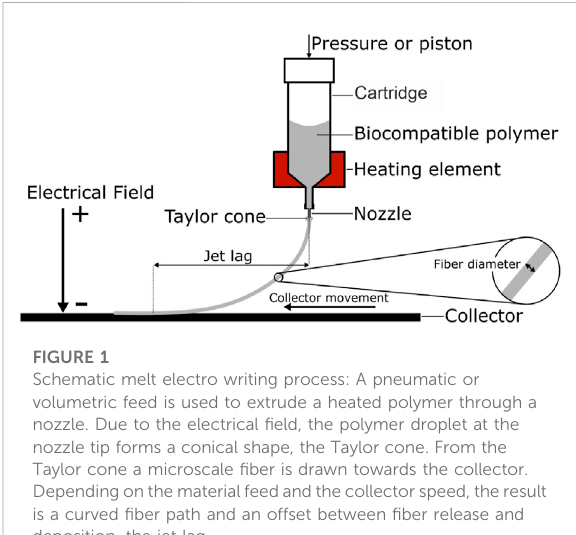
FIGURE 1 Schematic melt electro writing process: A pneumatic or volumetric feed is used to extrude a heated polymer through a nozzle. Due to the electrical fi eld, the polymer droplet at the nozzle tip forms a conical shape, the Taylor cone. From the Taylor cone a microscale fi ber is drawn towards the collector. Depending onthematerialfeedandthecollector speed, theresult is a curved fi ber path and an offset between fi ber release and deposition, the jet